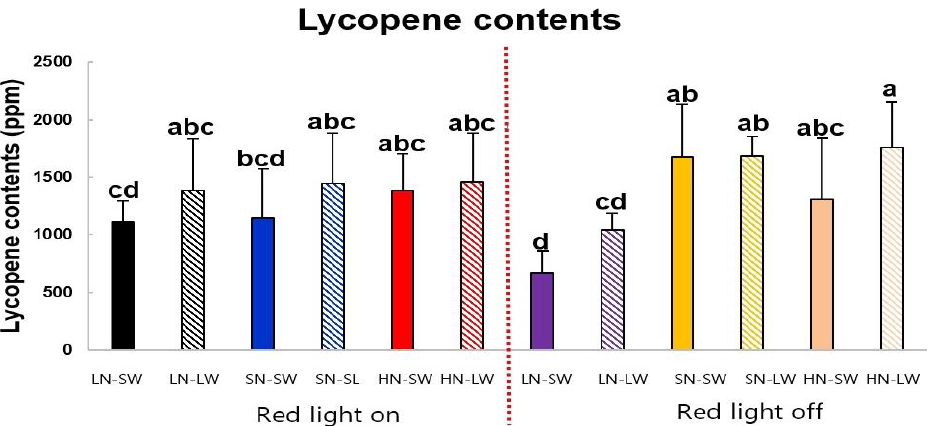
Figure 1. Lycopene contents of tomato fruits are influenced by nutrient, water, and light condition on a dry weight basis. LN, Low N; SW, sufficient water; LW, limited water; SN, standard N; HN, high N. Closed bars are sufficient water supply, and hatched bars are limited water supply. Mean values and standard deviations are presented (N = 5). The alphabetical letters above the bars mean significant differences in values by different nutrient × water × light conditions and they were determined by ANOVA followed by Duncan’s multiple range test ( p <